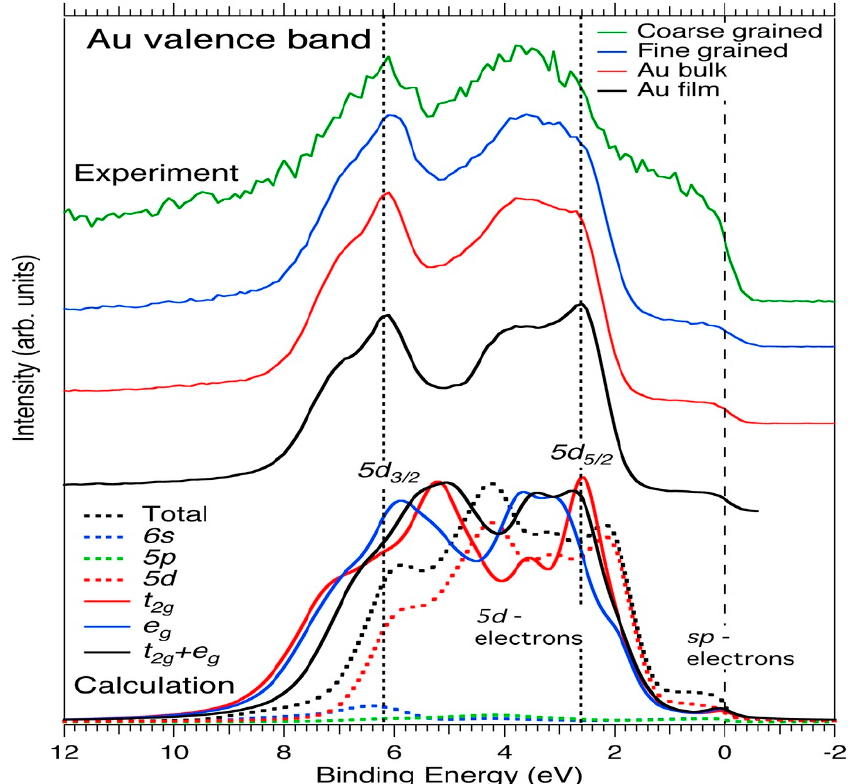
Figure 8. Experimental and calculated valence band spectra of film, bulk, fine-grained, and coarse- grained powder. The broken line connects the d -band edges and the apparent spin-orbit splitting maxima.